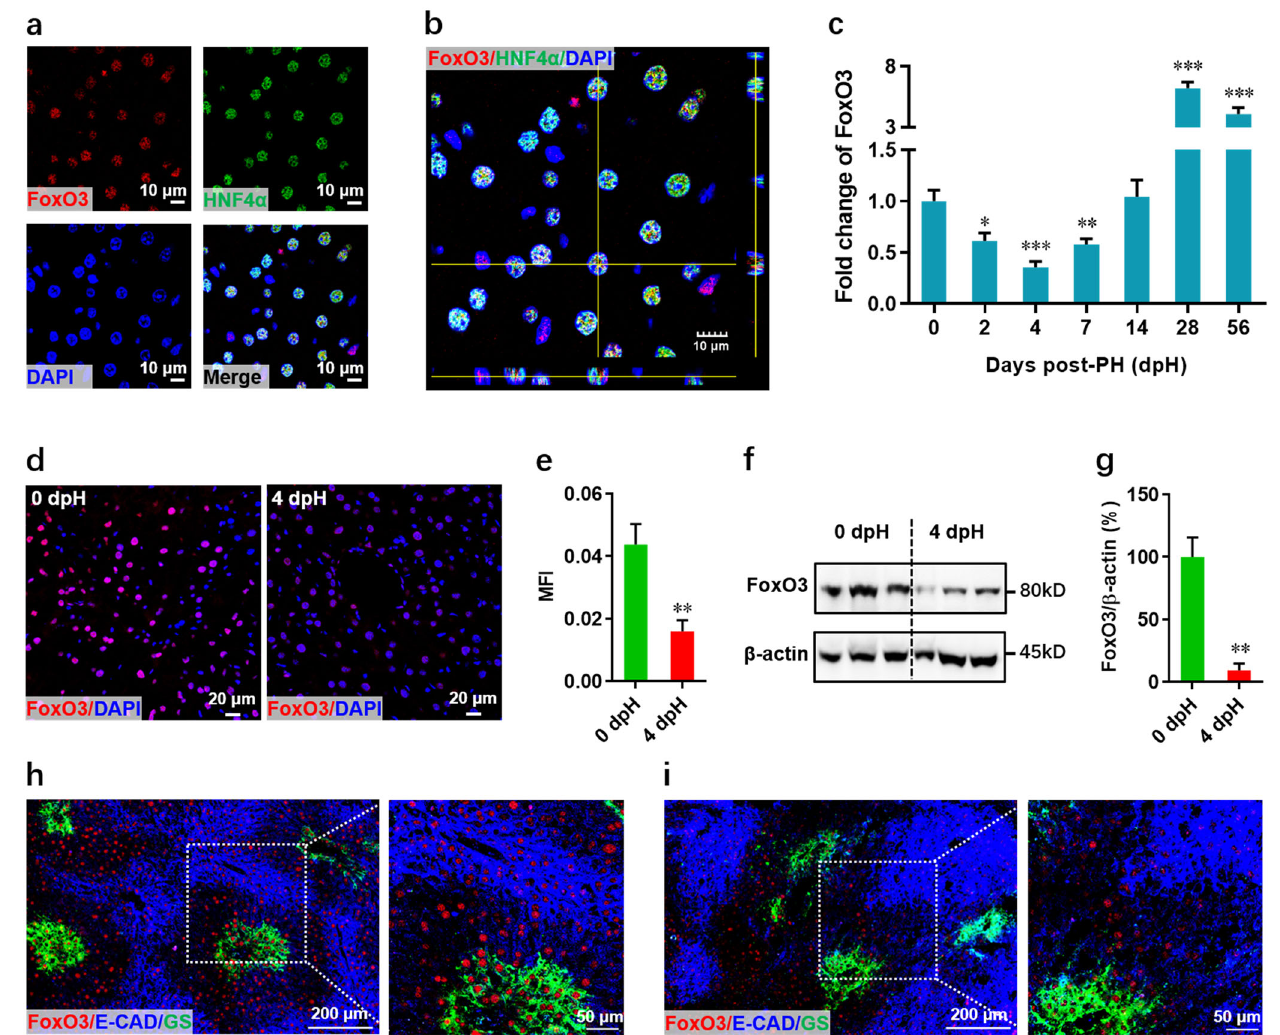
Fig. 1 FoxO3 expression patterns during liver regeneration in wild-type mice. a FoxO3 expression and localization in quiescent livers of adult mice (0 dpH) was identi fi ed by staining for FoxO3 (red), HNF4 α (green), and nuclei (blue). b Representative Z-stack confocal image of FoxO3-positive hepatocytes in liver. c Quanti fi cation of hepatic FoxO3 expression at the indicated time points after PH. Data are presented as the mean ± SEM ( n = 5 ~ 8 mice per group), * p < 0.05, ** p < 0.01, *** p < 0.001 versus quiescent livers at 0 dpH (one-way ANOVA test). (d and e) The expression and localization of FoxO3 in liver were detected by immuno fl uorescence staining in pre-PH and 4 dpH mice. (d) Representative images for each condition are shown. e Quanti fi cation of FoxO3 fl uorescence intensity was performed as described in the Methods section. Data are presented as the mean ± SEM ( n = 4 mice per group), *** p < 0.001 (Student ’ s t -test). f , g Representative images of Western blotting ( f ) and relative quanti fi cation ( g ) of FoxO3 protein levels in primary hepatocytes isolated from wild-type mice at pre-PH and 4 dpH. h , i Confocal staining of FoxO3, E-CAD (E-cadherin), and GS (glutamine synthetase) revealed a zone-independent expression manner of FoxO3 in livers at 0 dpH ( h ) and 4 dpH ( i ). Data are presented as the mean ± SEM ( n = 3 mice per group). ** p < 0.01 (Student ’ s t